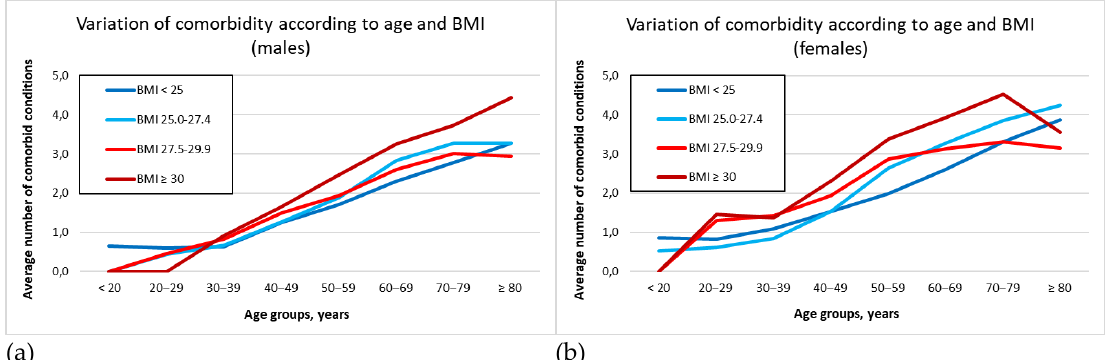
Figure 1. Variation of comorbidity according to age and BMI categories: ( a ) Males; ( b ) Females.